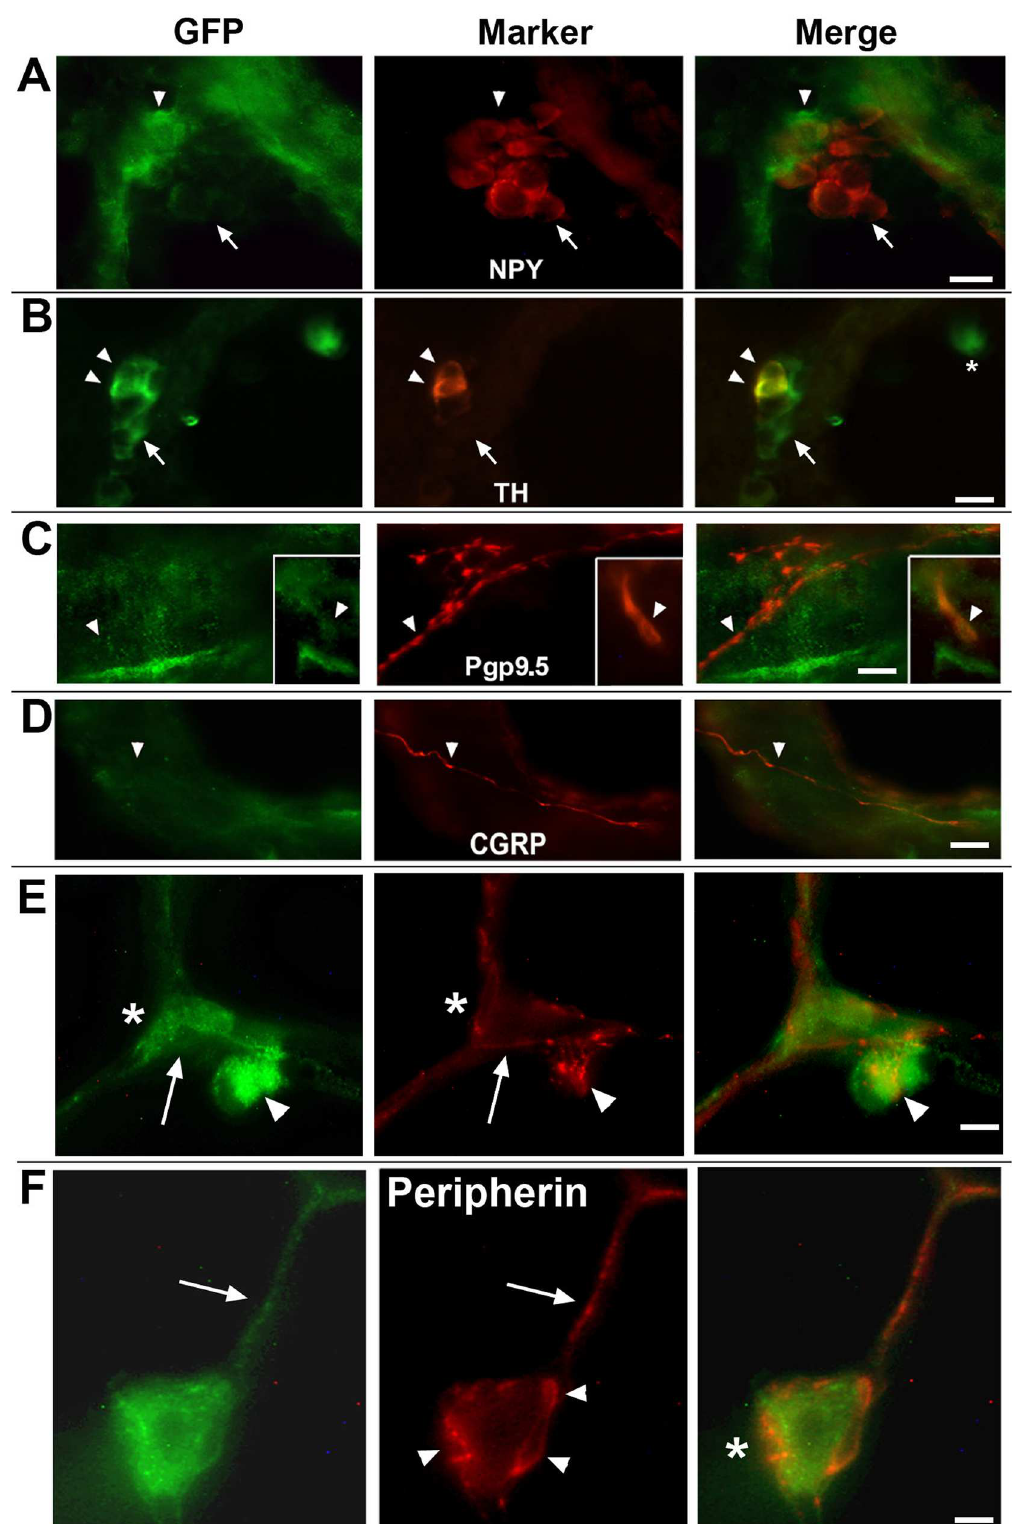
Fig 2. Immunohistochemical examination of the α 7 reporter by lung neuronal and neuroepithelial cells. Panels A through F show images of the α 7 reporter tGFP co-expression in lung sections co-stainedwith various